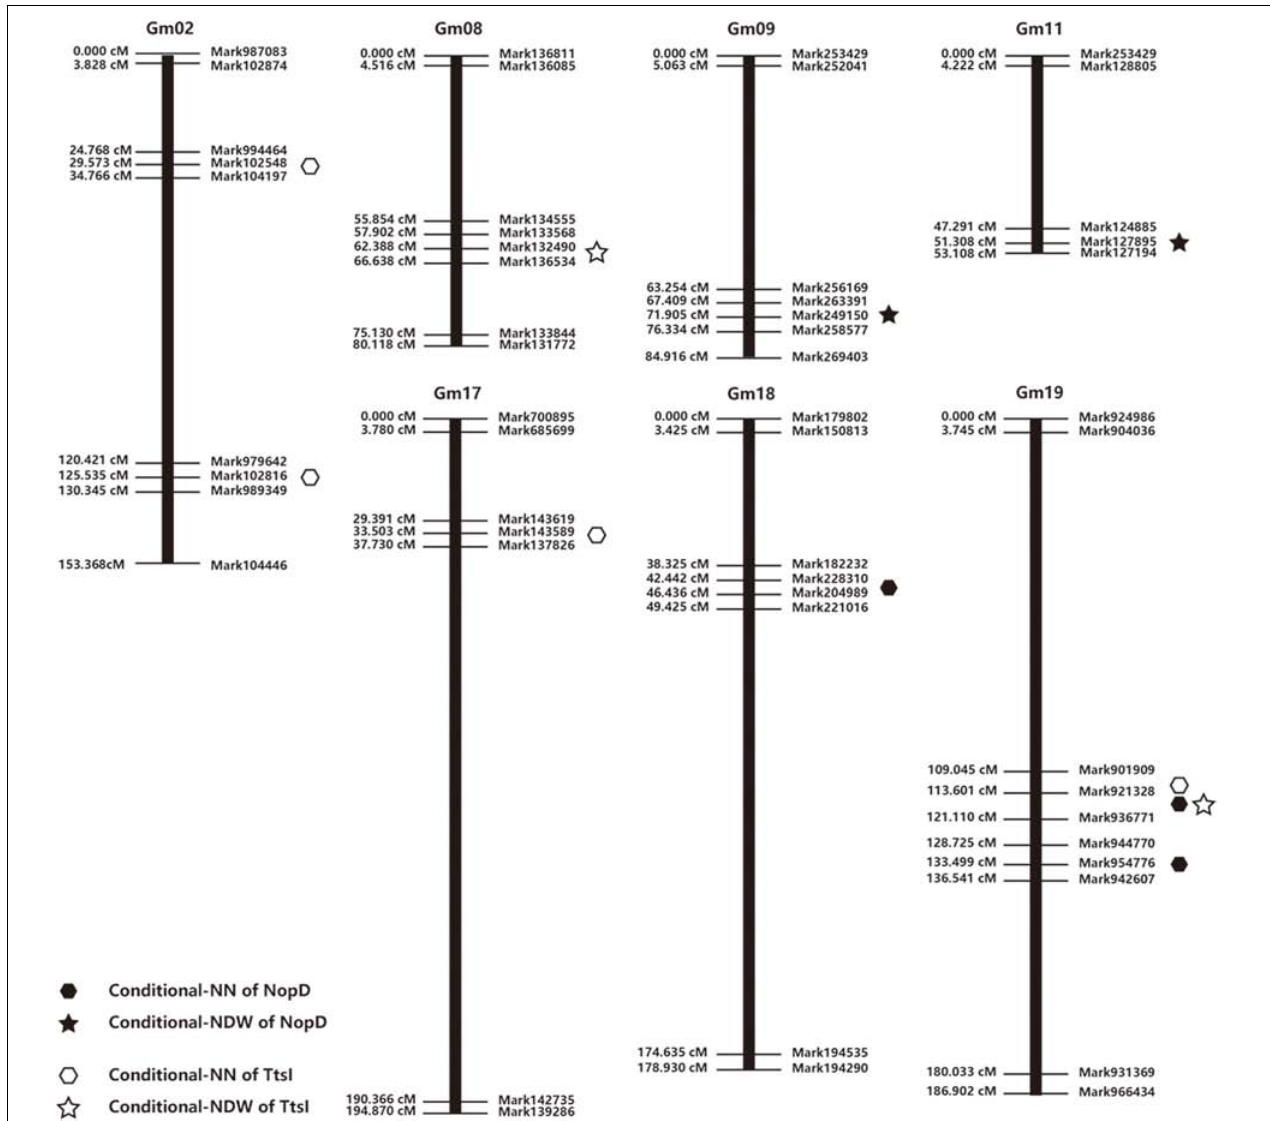
FIGURE 3 | Distribution of conditional quantitative trait locus (QTL) for nodule number and nodule dry weight among linkage groups and chromosomes.